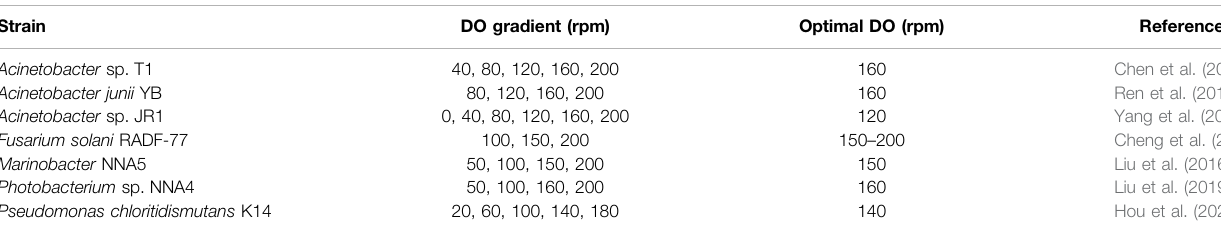
TABLE 8 | Ranges of dissolved oxygen (DO) for HNADs. Strain DO gradient (rpm) Optimal DO